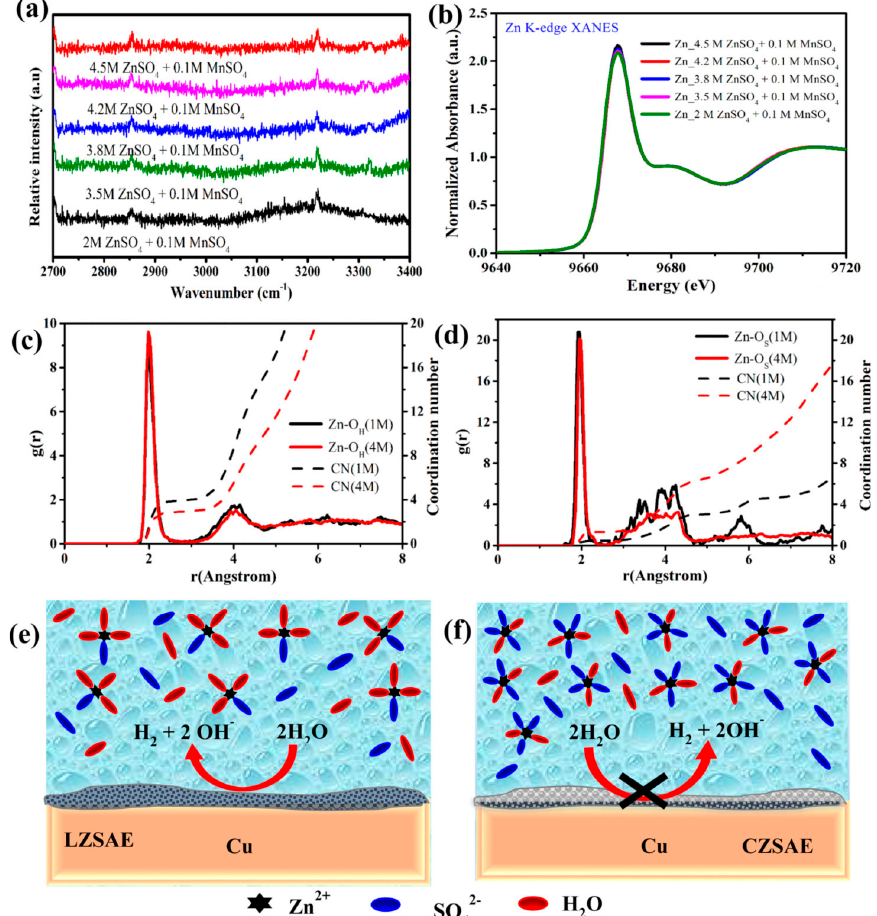
Figure 5. ( a ) Characteristic Raman spectra for different concentrations of zinc-salt electrolytes and ( b ) Zn K-edge XANES for different concentrations of zinc-salt electrolytes. RDFs (solid line), g(r), and the corresponding integrals of CNs (dashed line), for ( c ) Zn-OH and ( d ) Zn-OS with salt concentration from 1 M (black) to 4 M (red) at 300 K, schematic representation for the passivation layer (Zn 4 (OH) 6 SO 4 -xH 2 O) formation and solution structure during Zn plating in ( e ) LZSAE and ( f ) CZSAE systems. Reproduced with permissions from the Ref. [56]. Copyright © 2020 American Chemical Society.